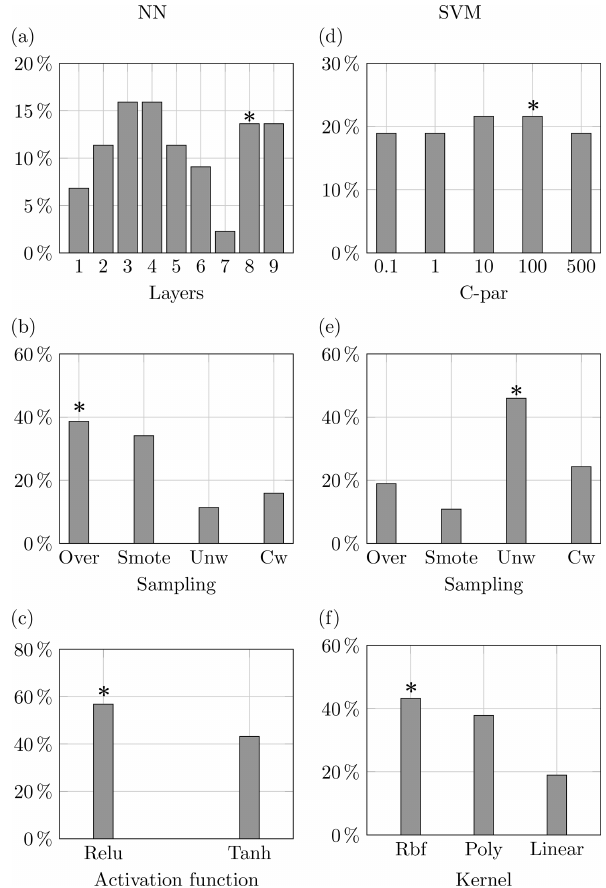
Figure 11. Properties of top 1% model configurations for the flood case. The stars denote the characteristics of the best-performing configurations according to the highest area under the precision- sensitivity